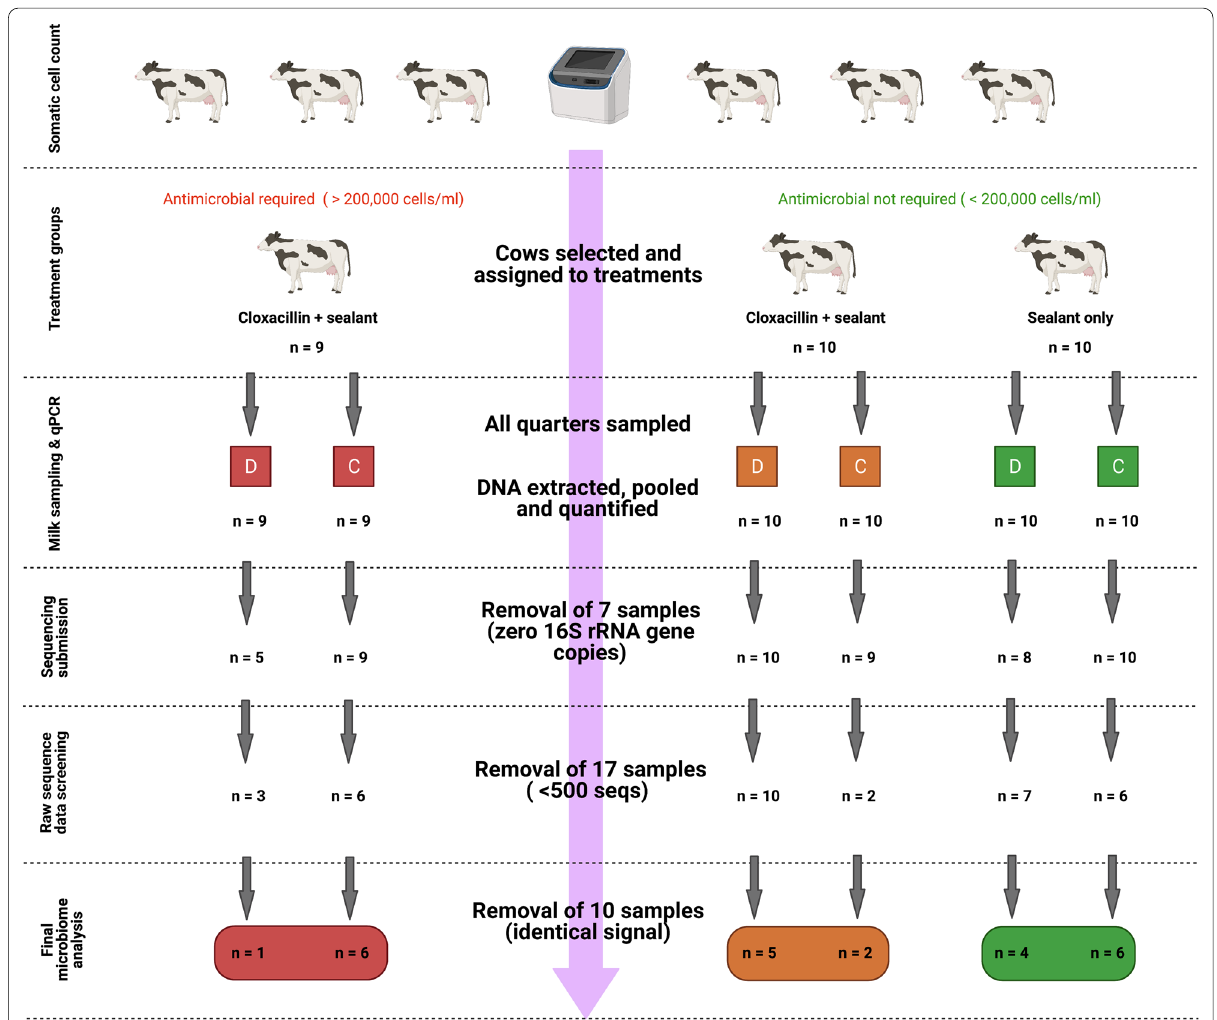
Fig. 1 Experimental design and sample workflow from milk collection to the final 16S rRNA gene sequencing analysis. Samples included in the final analysis were subject to filtration based on 16S rRNA gene qPCR counts, 16S rRNA gene sequence counts and an exogenous contamination screen. Drying off D, Calving C. This Figure was created using BioRe nder. = =